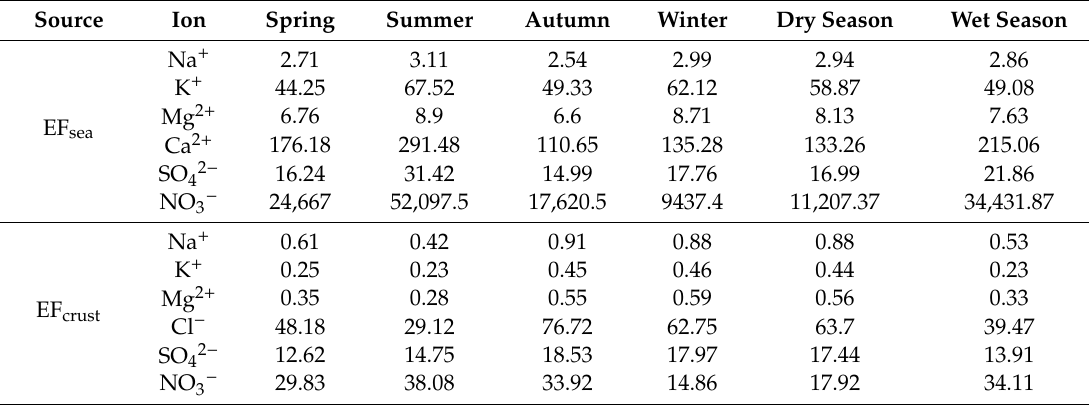
Table 9. Seasonal variation of enrichment factor (EF) of the main